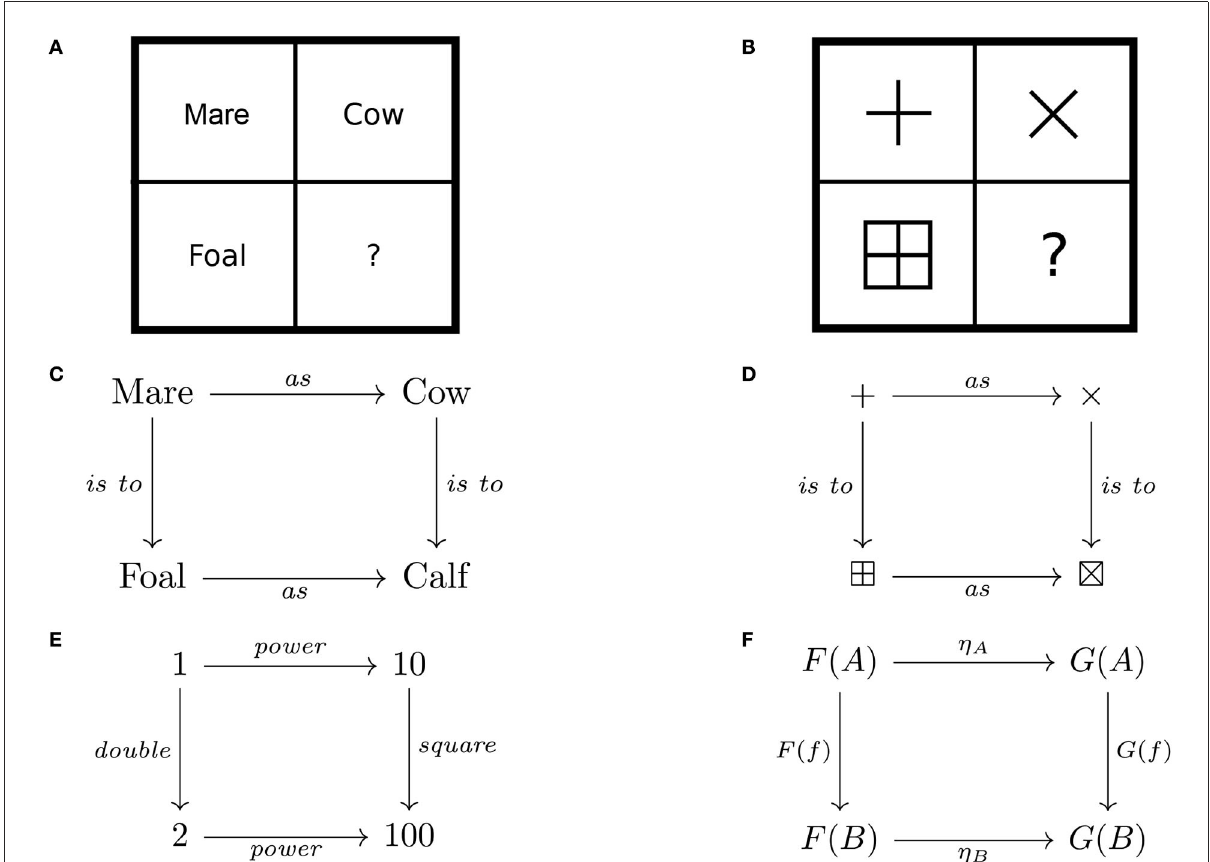
FIGURE3 A comparison of proportional analogy, matrix reasoning, and natural transformation: (A) “Mare is to foal as cow is to calf” and (B) “ + is to ⊞ as × is to ⊠ ” in matrix form, and (C,D) in the form of a natural transformation. Algebraic relations, for example, (E) the power function are also instances of natural transformations, whose general form is given as (F) a commutative square of